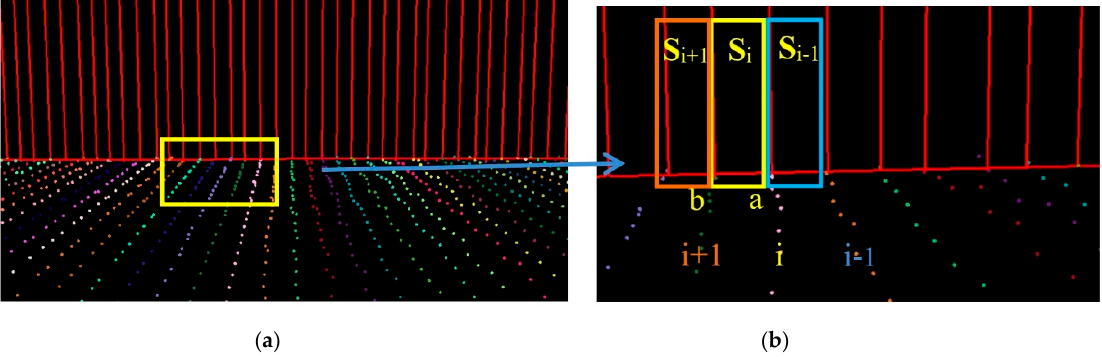
Figure 4. Trajectory auxiliary for each scan line ( a ) and definition of each auxiliary surface ( b ); a and b: Points in i and i+1 scan lines, respectively. Si: Auxiliary plane corresponding to i scan line.